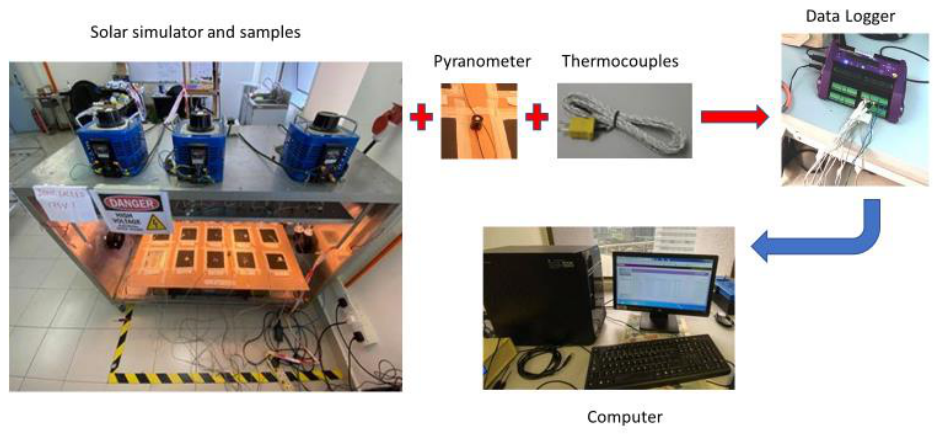
Figure 2. Indoor experimental